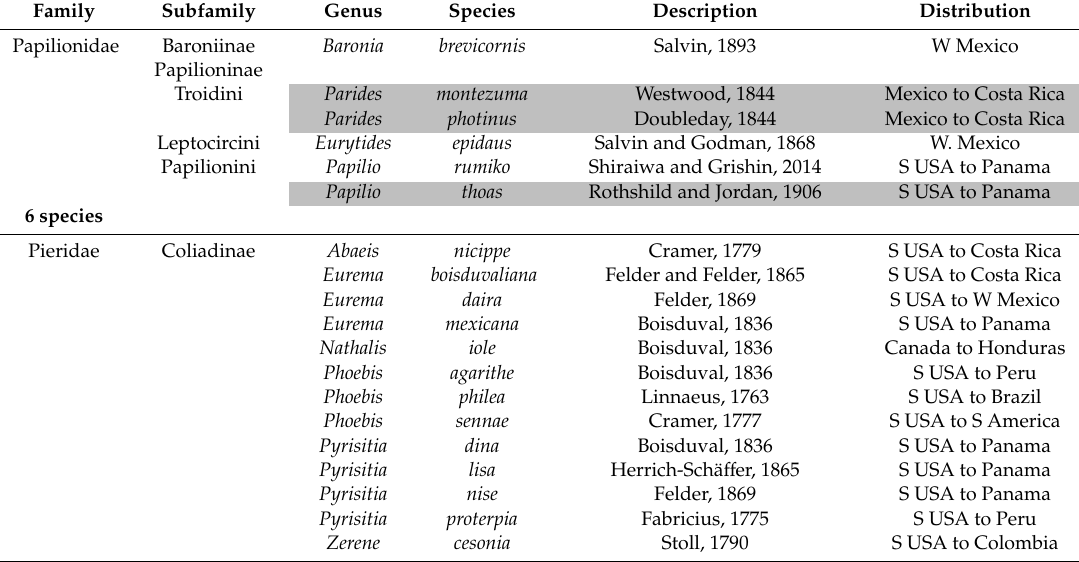
Table A1. Complete list of Lepidoptera collected during this study, including their distributions. Note that descriptions correspond to the local subspecies [64] including the name change of Papilio cresphontes for Papilio rumiko (see description of this species). Highlighted in gray are the species with only a few individuals sampled, which were excluded from statistical